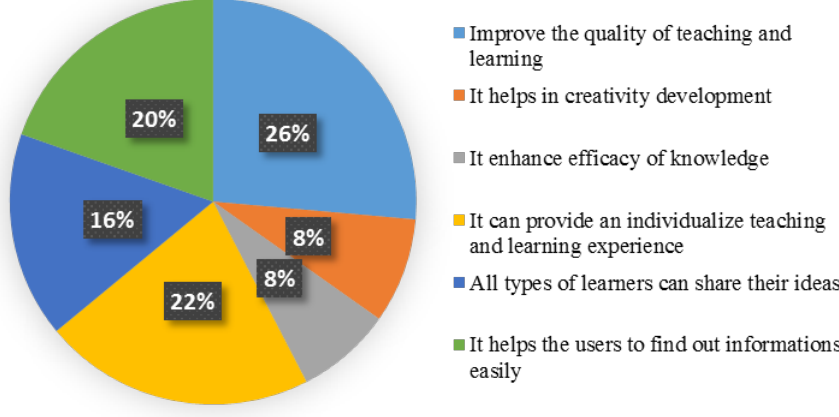
Figure - 5: Showing the importance of online learning for